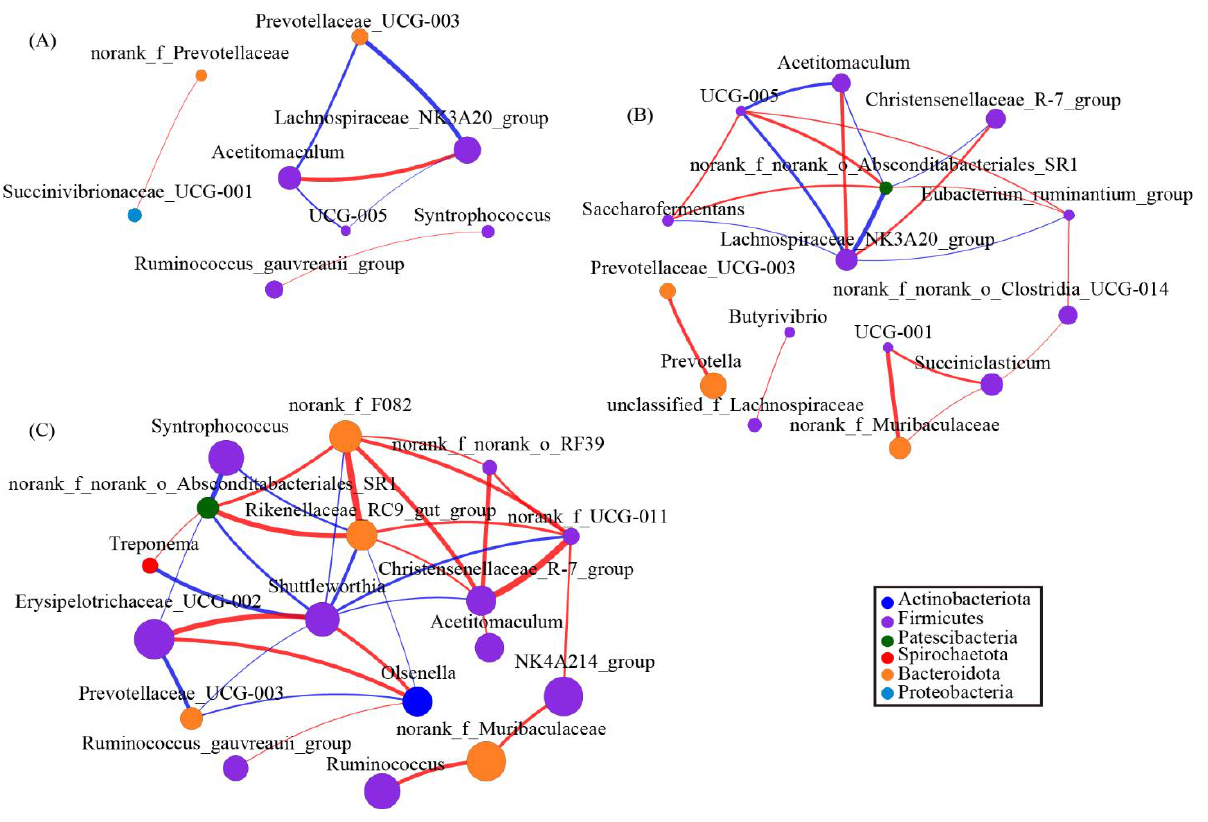
Figure 6. The network of co-occurring genera within the rumen microbiota supplied with different amounts of Acremonium terricola culture: ( A ) 0 and 30 g/d; ( B ) 0 and 60 g/d; ( C ) 0 and 300 g/d. The figure shows genera based on Spearman’s correlation. The nodes represent the core genera, and the size of each node is proportional to the degree. The edges stand for strong (Spearman’s correlation coefficient r > 0.7 or r < −0.7) and significant ( p < 0.05) correlations between core genera. The nodes are colored based on phylum. Red and blue lines represent positive and negative correlations between two nodes, respectively.